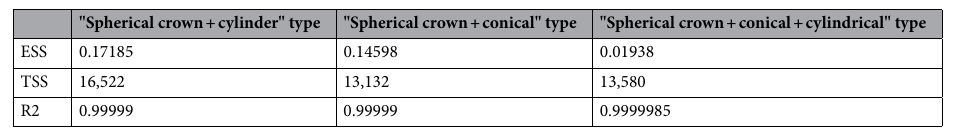
Table 2. Validation